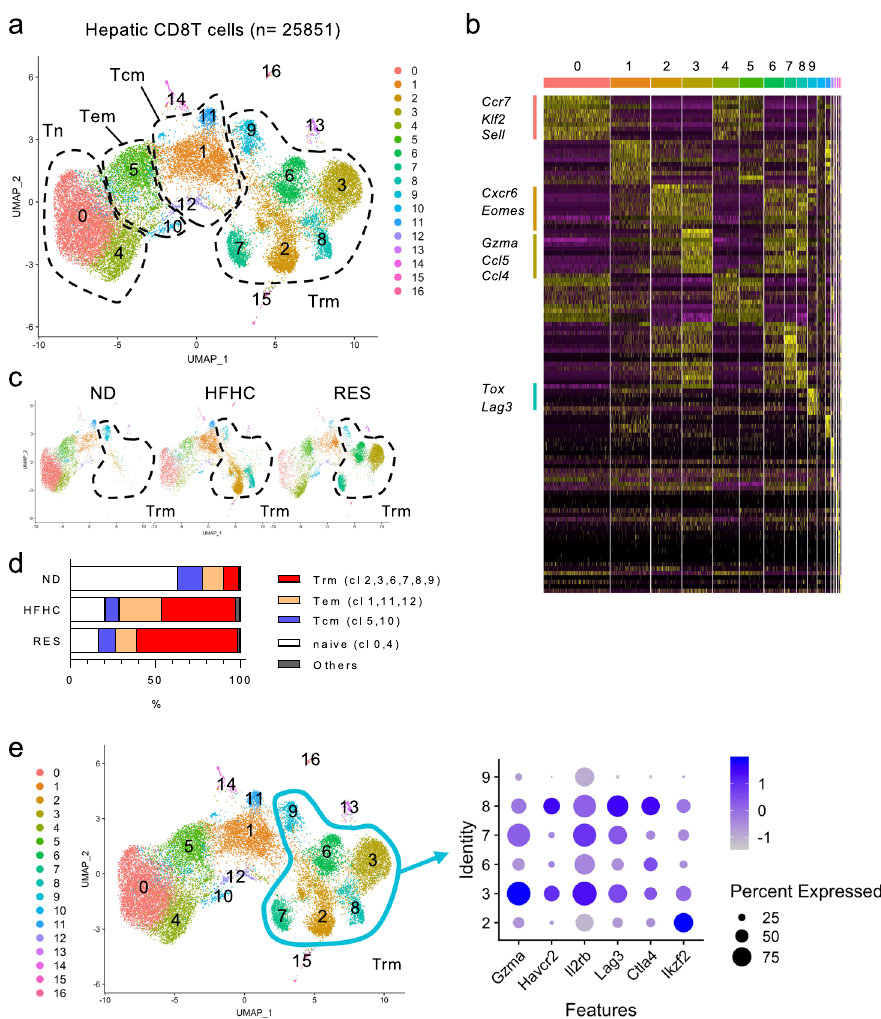
Fig. 3 Landscape of CD8 + T cells in NASH and NASH resolution livers. a – d ScRNA-seq analysis of liver CD8 T cells. a UMAP projection of combined liver CD8 + T cells ( n = 25,851) derived from ND, HFHC, and RES (5 weeks) mice, showing the formation of 17 main clusters represented by different colors. The functional description of each cluster is determined by the gene expression characteristics of each. b Heat map of 17 CD8 + T cell clusters with top 10 unique signature genes. c UMAP projection of liver CD8 + T cells derived from ND (left), HFHC (middle), and RES (right) mice. d Fractions of fi ve clusters (naïve, Tcm, Tem, Trm, and others) in CD8 + T cells. e Dot plot visualizing the expression of representative genes in the Trm clusters (cluster 2, 3, 6 – 9). The color represents the average expression level, and the circle size represents the proportion of cells expressing each gene. Source data are provided as